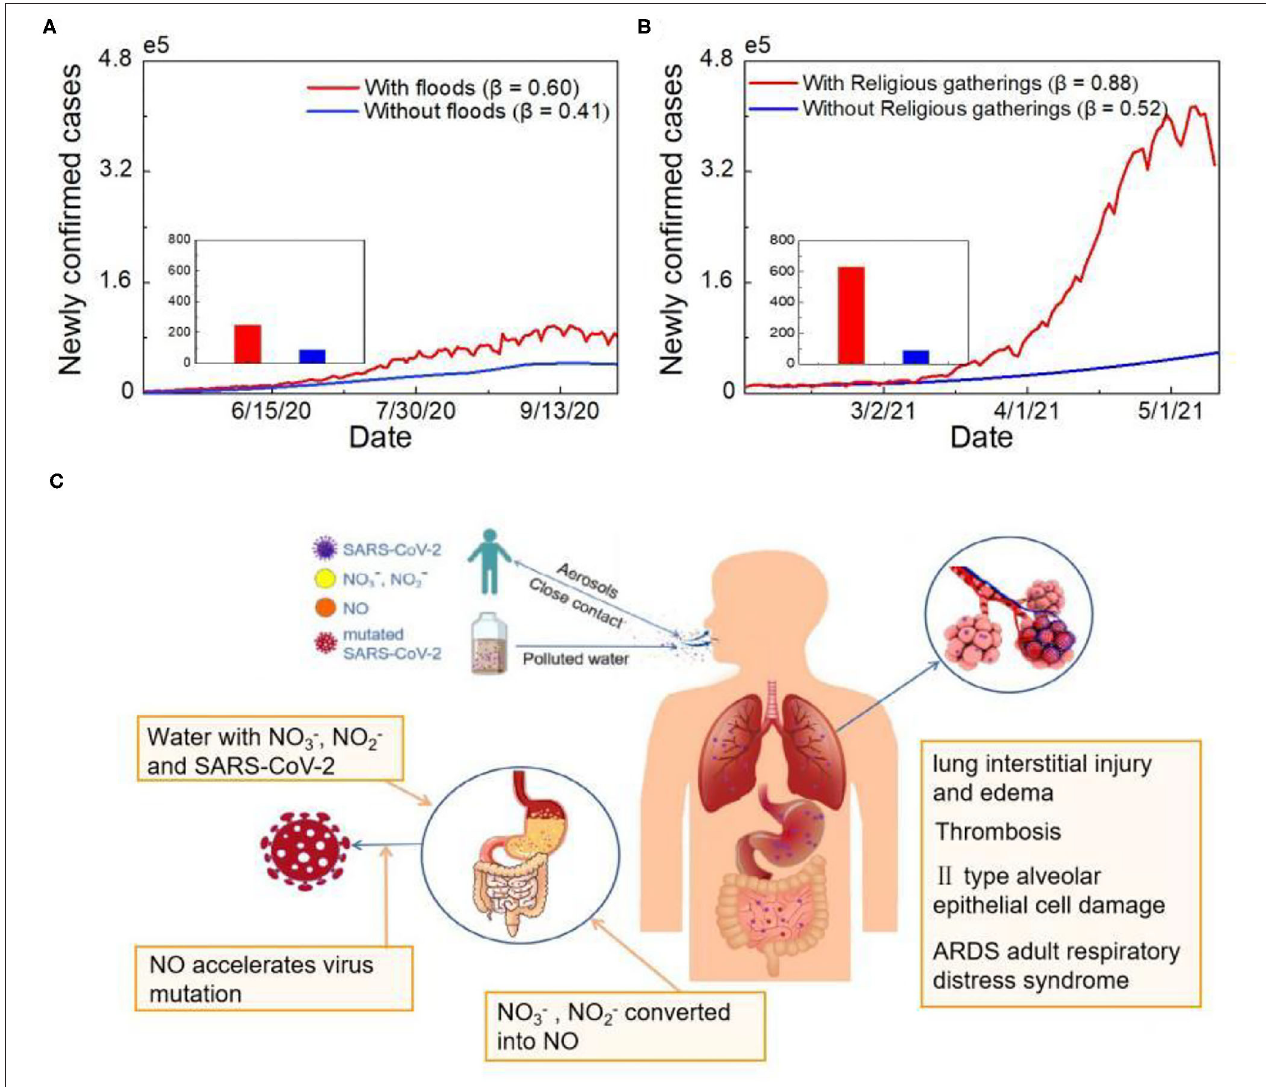
FIGURE 4 | Simulated analysis of COVID-19 human-to-human and water-to-human transmission. (A) Epidemic simulation of newly confirmed cases without floods. The red line represents the actual number of cases, and the blue line shows the number of newly confirmed cases simulated without floods. (B) Epidemic simulation of newly confirmed cases without holding Kumbh Mela. The red line represents the actual number of cases, and the blue line shows the number of newly confirmed cases simulated without religious gatherings. (C) The COVID-19 human-to-human and water-to-human transmission